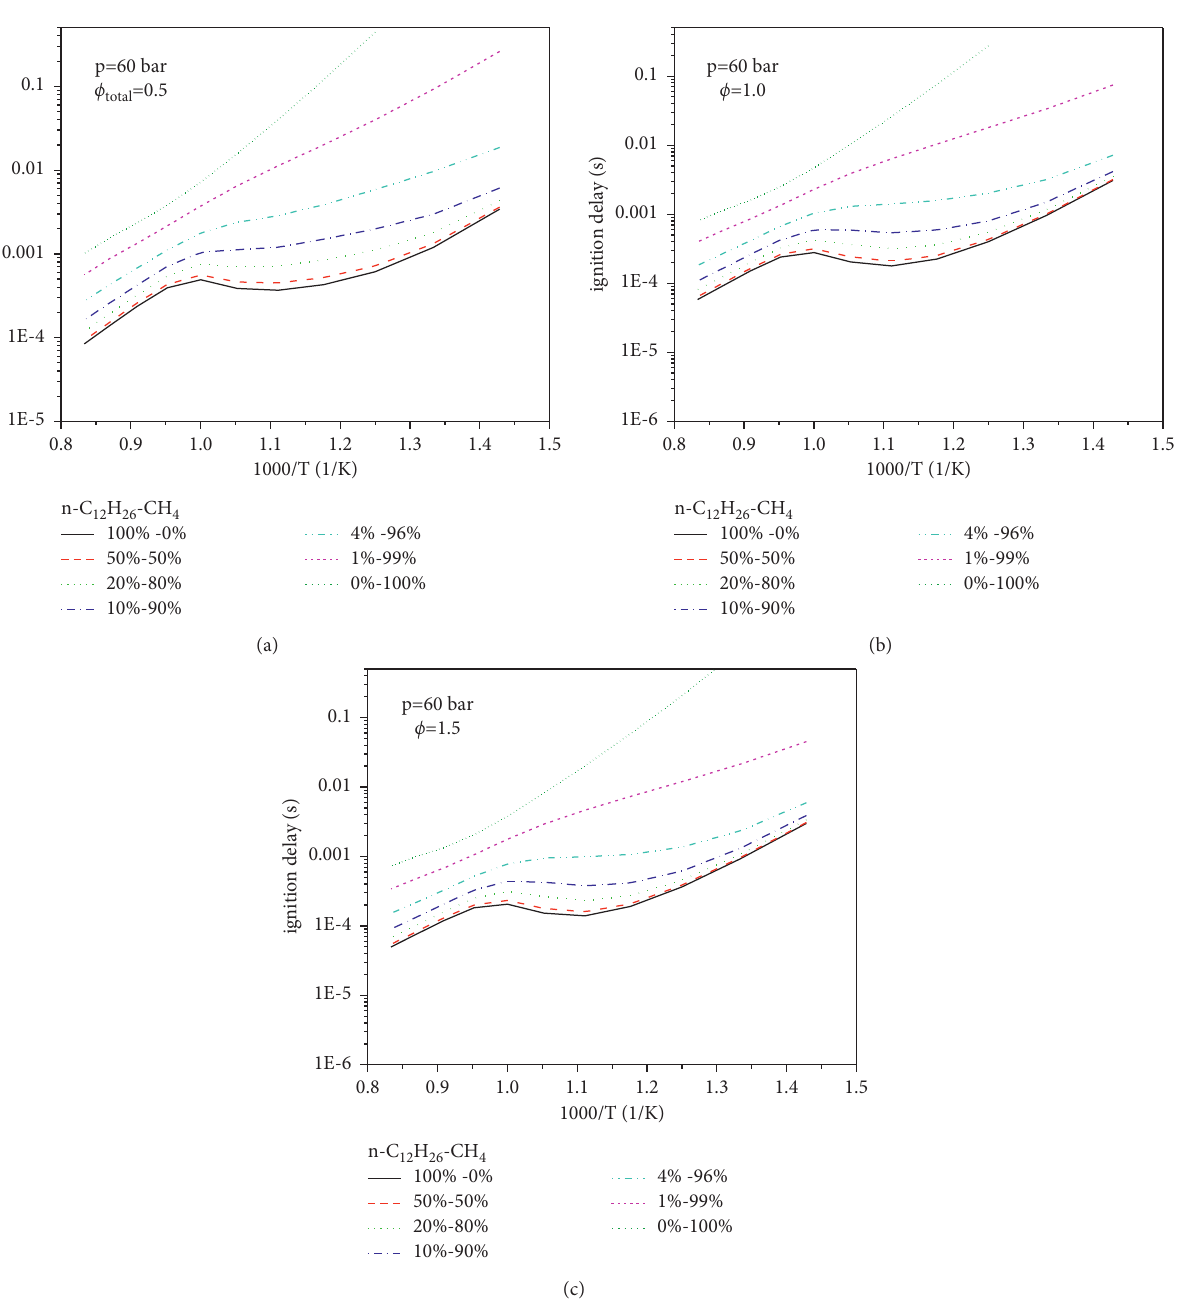
Figure 6: Ignition delay of different n-dodecane mixing